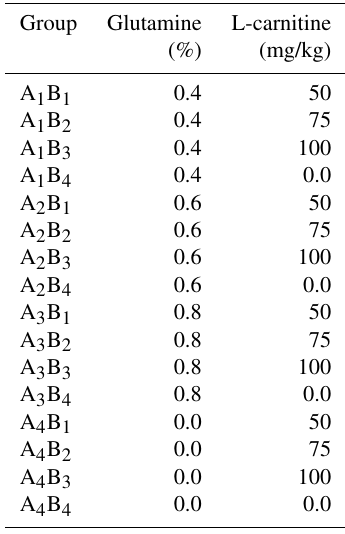
Table 1. Orthogonal experimental design L 16 (4 5